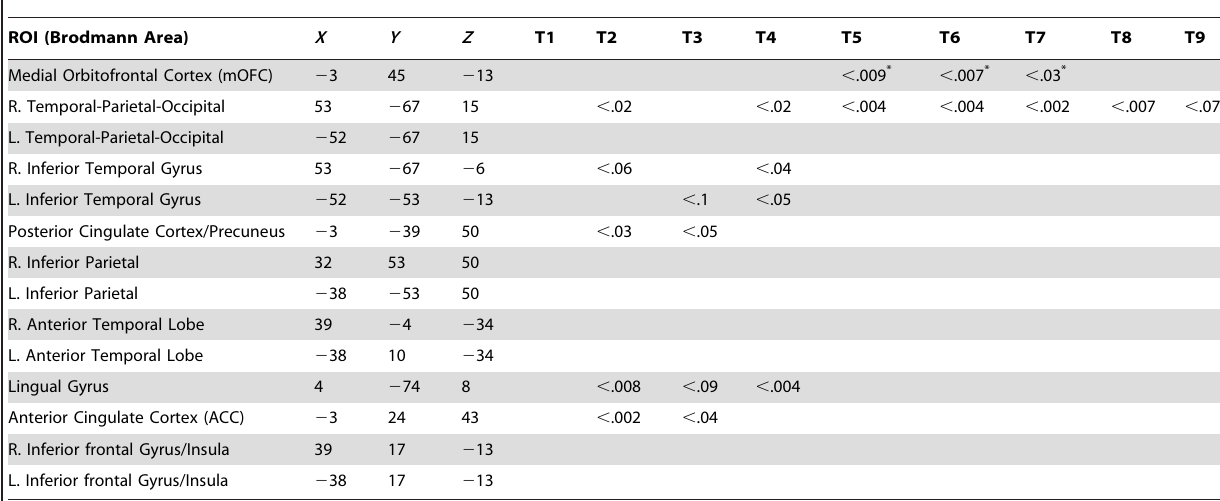
Table 1. Paired sample t Tests results for each region of interest across time.